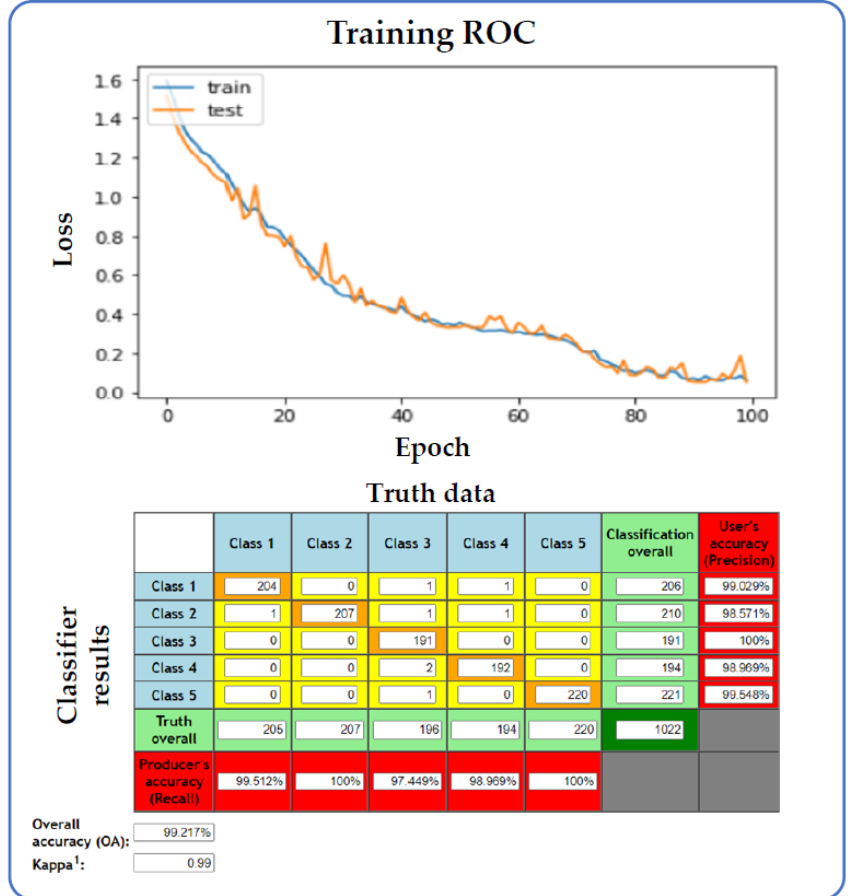
Figure 9. Phase 4 — Model 7 of 12 models: 10 pps, stimulation (Slots 2 – 5), comparing five classes (EEG Delta, Theta, Alpha, Beta and Gamma bands). For this model, the train-to-test ratio was 4:1, with kappa = 0.990, area under the ROC curve (AUC) = 0.998 and F-measure = 0.992.